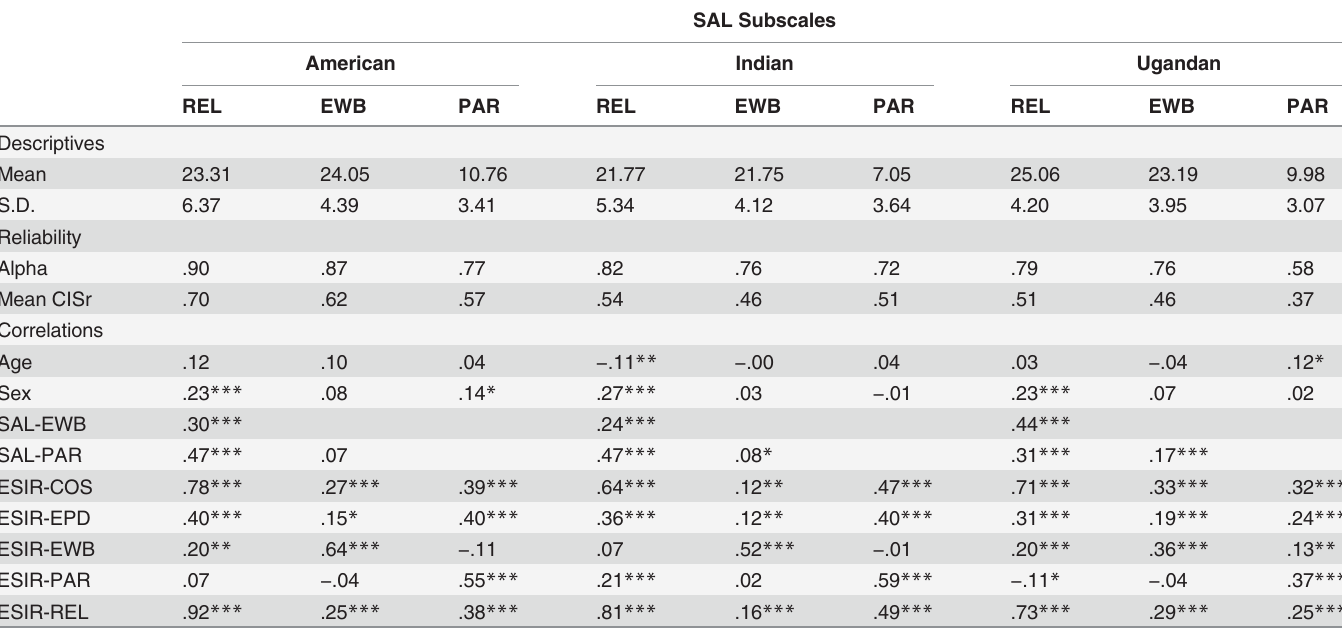
Table 19. Descriptive Statistics, Reliabilities, SAL Subscale Inter-correlations and Correlations with ESI-R Dimensions Across American, Indian, and Ugandan